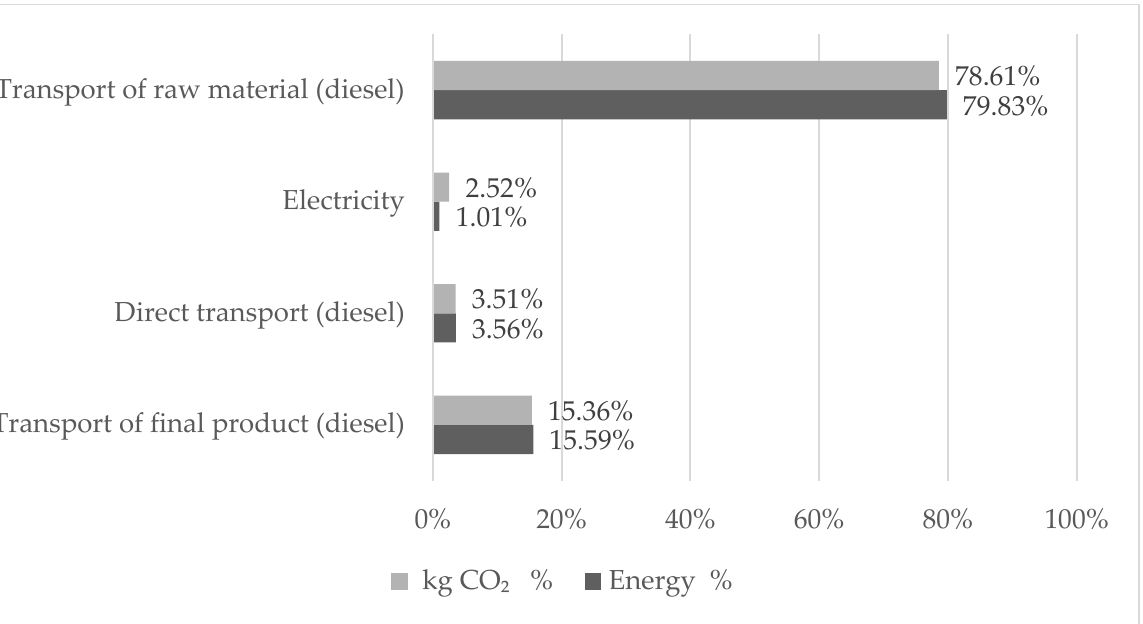
Figure 5. Embodied energy and CO 2 emissions for each stage and type of energy consumed.